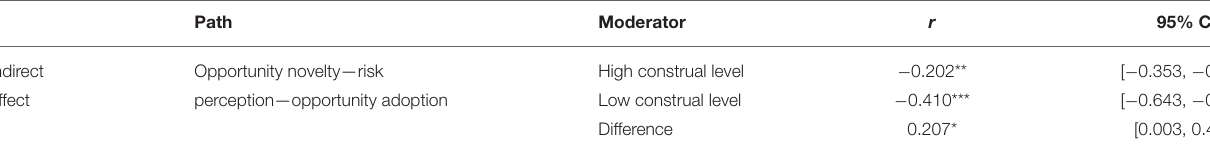
TABLE 7 | Results for the moderated mediation.